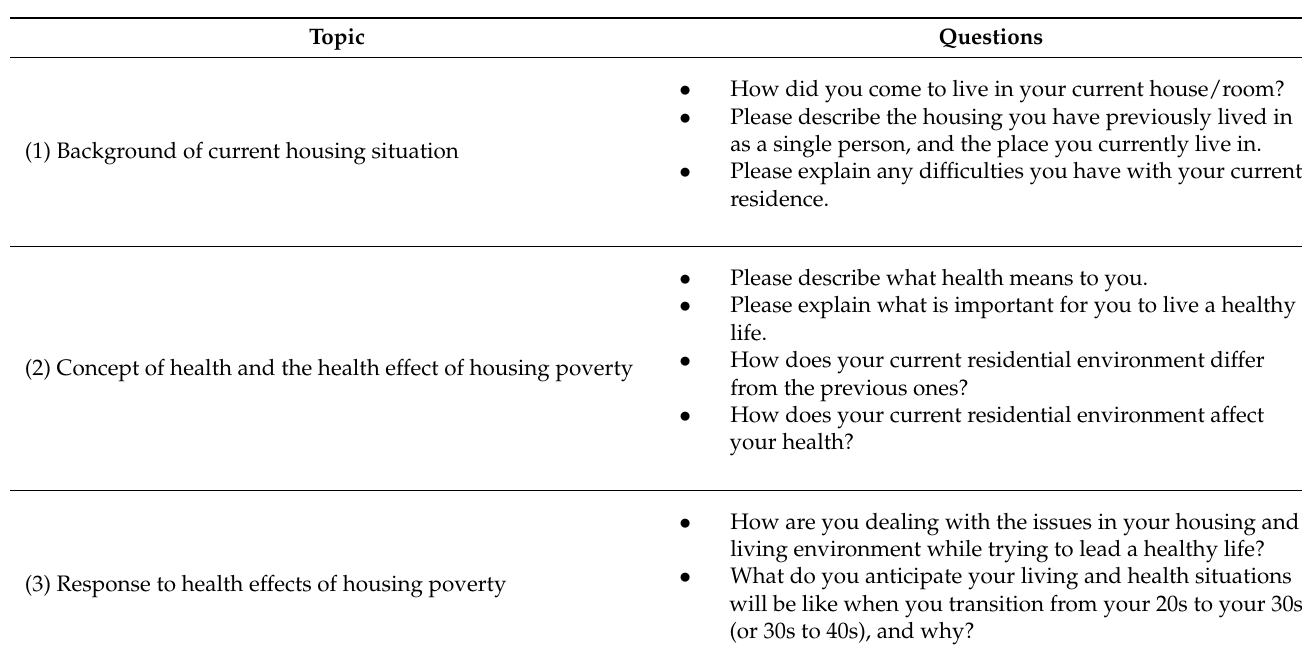
Table 1. Interview